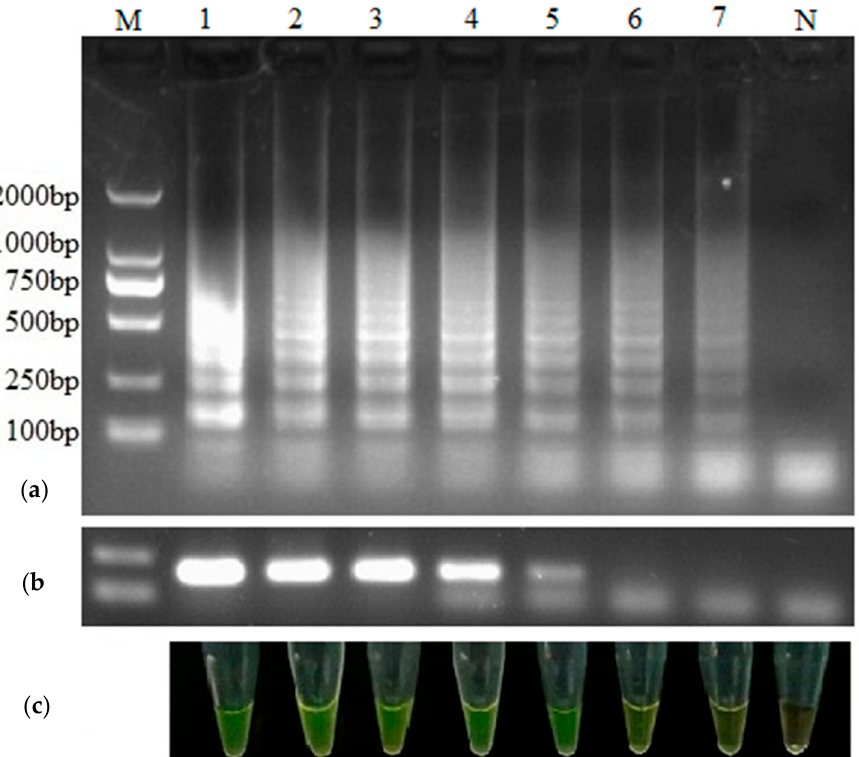
Figure 3. Comparison of the sensitivity between RT-LAMP and RT-PCR for PEDV. Ten-fold serial dilutions of the PEDV RNA (100 ng/ μ L) were used as template for RT-LAMP and conventional RT-PCR. Amplified products of RT-LAMP ( a ) and RT-PCR ( b ) were visualized by agarose gel electrophoresis and by naked eye with addition of SYBR Green I ( c ). Lane M: DL2000 DNA marker; Lanes 1–7: total RNA serially diluted 10-fold from 100 ng/ μ L to 0.0001 ng/ μ L per reaction; Lane N: negative control.